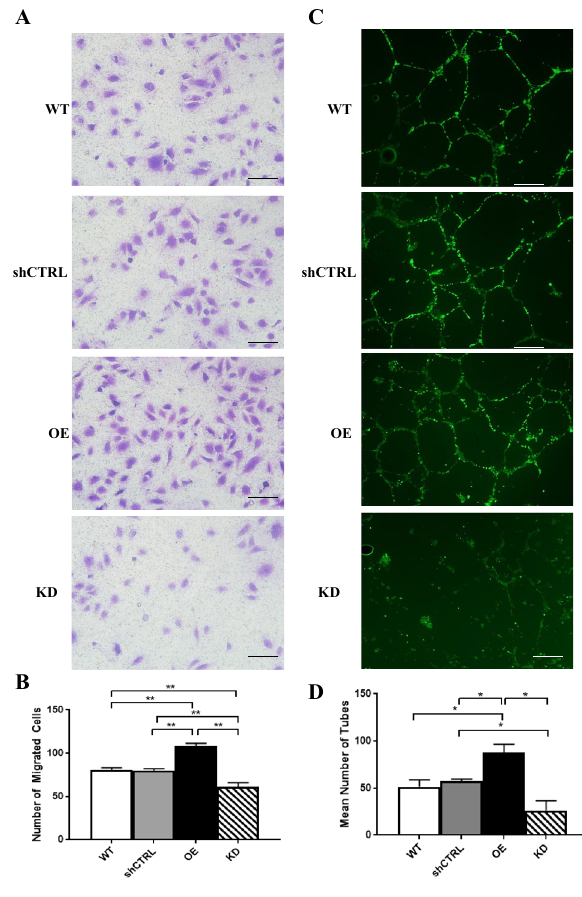
Figure 6. EMP2 expression regulates migration and tube formation of HUVEC endothelial cells. ( A ) Conditioned media was isolated from WT, shRNA control, OE, and shRNA KD#2 (labeled as KD) ARPE- 19 cells exposed to 4 h of hypoxic stress (0.5% O2) and used in a transwell cell migration assay. Numbers of migrated cells were imaged and quantified ( B ). Three independent experiments were conducted, and statistical significance was established using Student’s t -test (unpaired, two-tailed). Bar diagrams depict mean values and standard error of the mean. Scale bar = 50 µm. ( C ) The morphology of HUVEC cells was analyzed following growth in WT, shRNA control, OE, and shRNA KD ARPE-19 conditioned media. Coverslips were stained with Calcein AM, imaged, and the number of tubes manually counted in a masked fashion. ( D ) Quantification of the number of tubes imaged above. Experiments were repeated three times, and statistical significance was established using an ANOVA test/Student’s t -test (unpaired, two-tailed). Bar diagrams depict mean values and standard error of the mean. Scale bar = 50